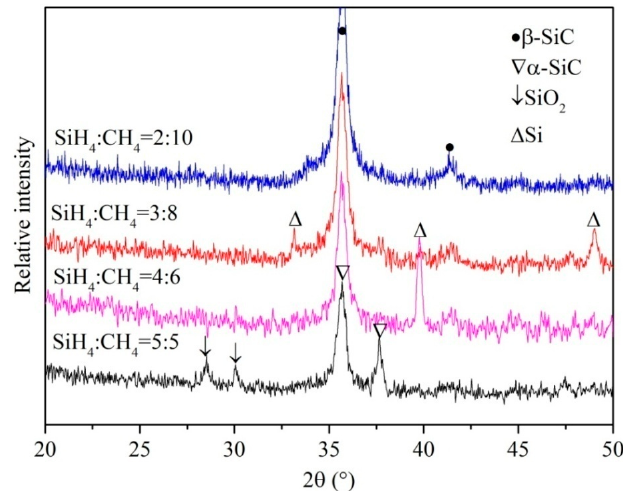
Figure 3. X-ray diffraction (XRD) patterns of the annealed thin films deposited with different ratios of SiH 4 to CH 4 .